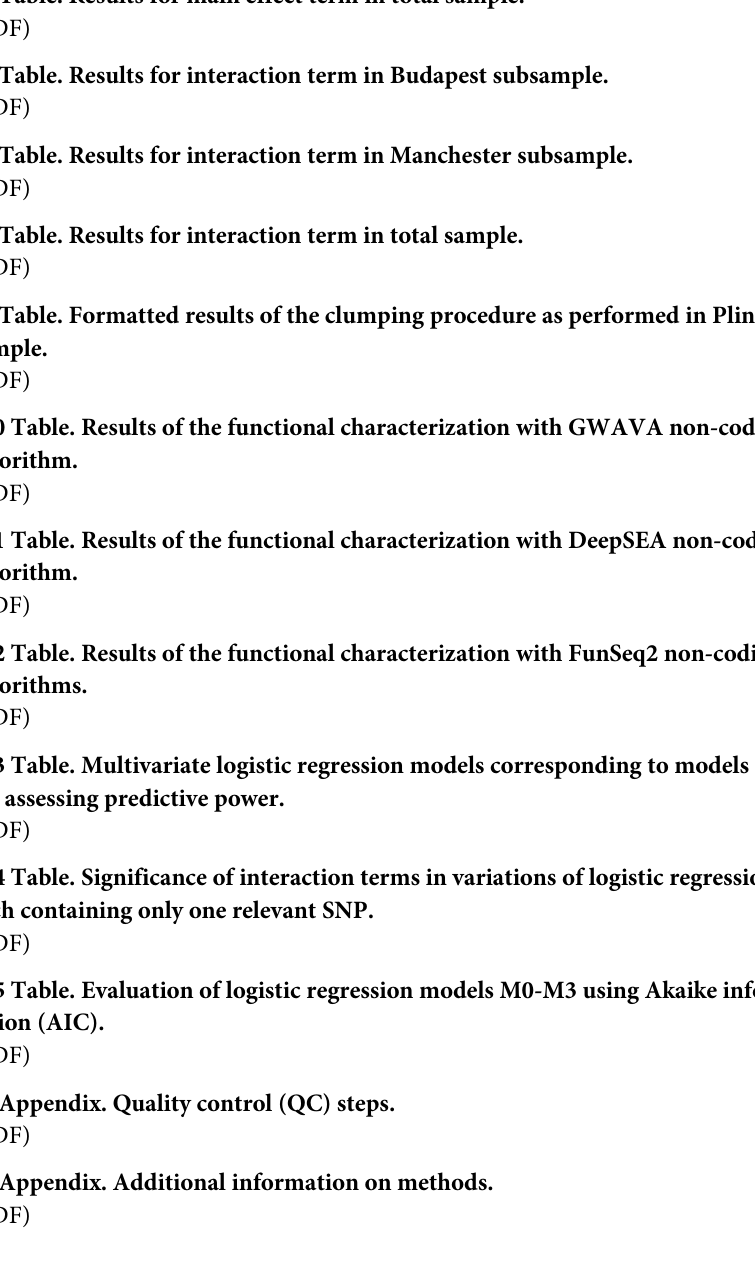
S3 Table. Results for main effect term in Budapest subsample. S4 Table. Results for main effect term in Manchester subsample. S5 Table. Results for main effect term in total sample. S6 Table. Results for interaction term in Budapest subsample. (PDF) S7 Table. Results for interaction term in Manchester subsample. (PDF) S8 Table. Results for interaction term in total sample. (PDF) S9 Table. Formatted results of the clumping procedure as performed in Plink on the total sample. (PDF) S10 Table. Results of the functional characterization with GWAVA non-coding scoring algorithm. (PDF) S11 Table. Results of the functional characterization with DeepSEA non-coding scoring algorithm. (PDF) S12 Table. Results of the functional characterization with FunSeq2 non-coding scoring algorithms. (PDF) S13 Table. Multivariate logistic regression models corresponding to models M0-M3 used for assessing predictive power. S14 Table. Significance of interaction terms in variations of logistic regression model M3 each containing only one relevant SNP. S15 Table. Evaluation of logistic regression models M0-M3 using Akaike information cri- terion